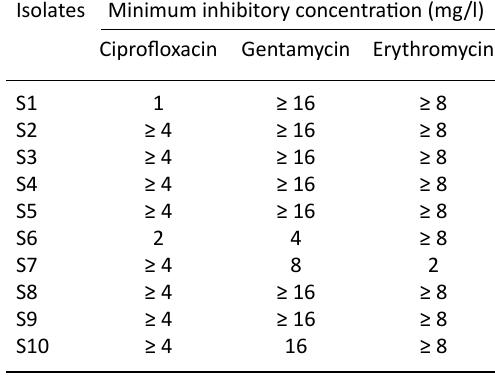
Table 3. Minimum inhibitory concentration values of different antibiotics Isolates Minimum inhibitory concentration (mg/l)